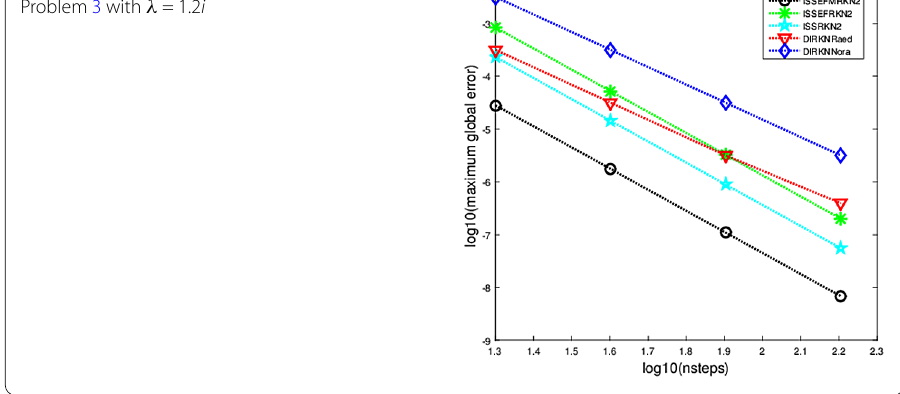
Figure 3 Maximum global error in the solution for Problem 3 with λ = 1.2 i